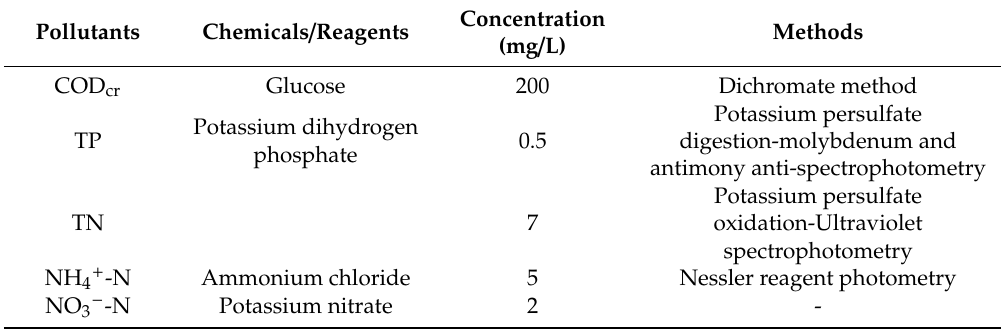
Table 1. Simulated water sample preparation method and index determination